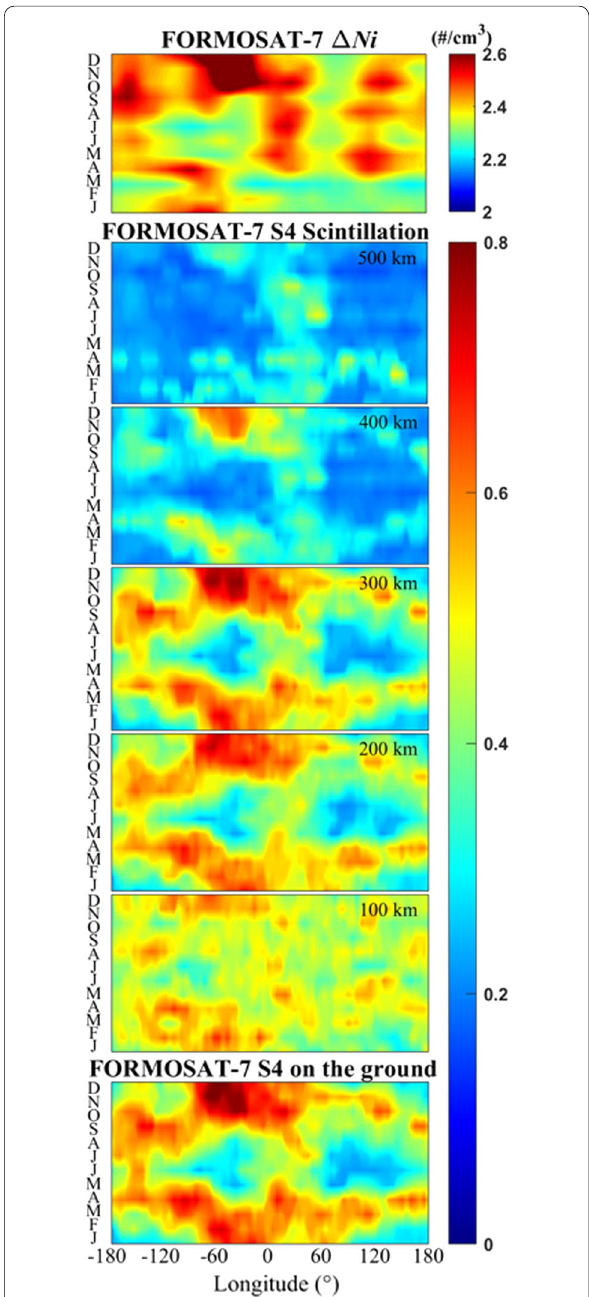
Fig. 19 The month‑longitude distribution of F7/C2 IVM and TGRS observations within 15‑deg magnetic latitude during the nighttime ± of 2000–0000 LT in 2020. The IVM deviation ion density (ΔNi, top panel) and the S4 scintillation index at 500, 400, 300, 200, and 100 km altitude and on the ground (bottom